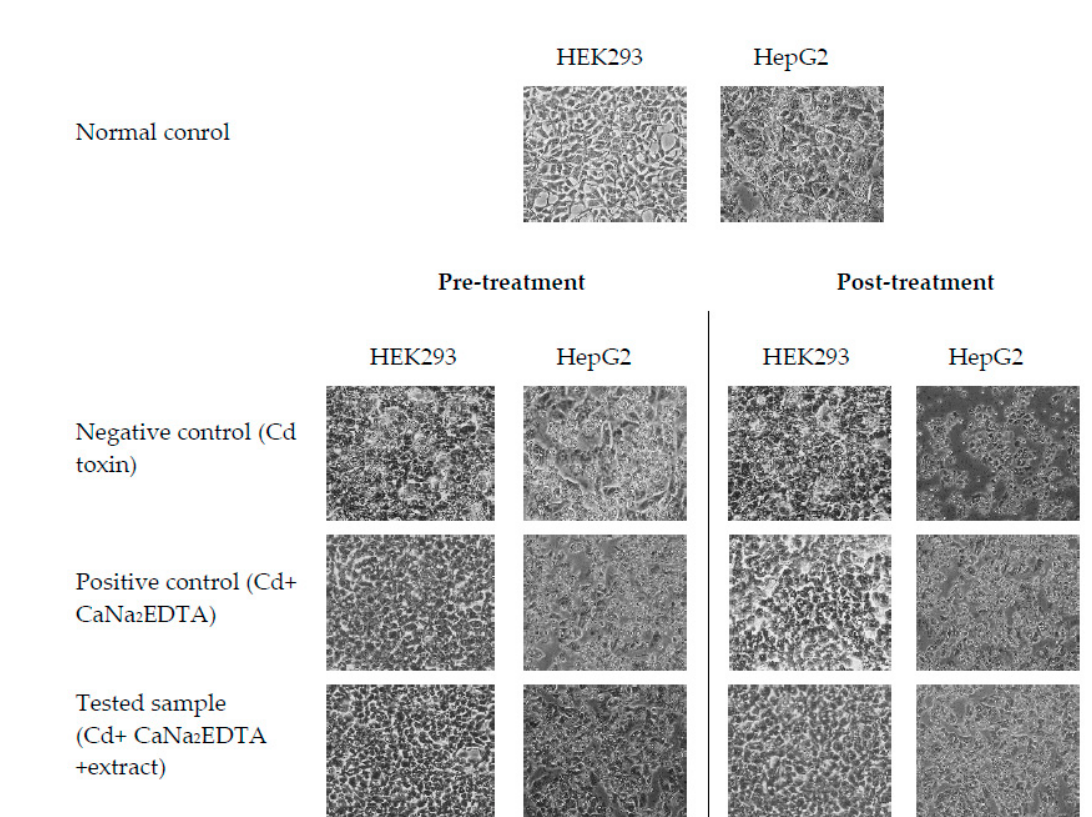
Figure 6. Morphology of HEK293 and HepG2 cells treated with Cd-induced toxicity and crude extract coupled with CaNa 2 EDTA in pre- and post-treatments.